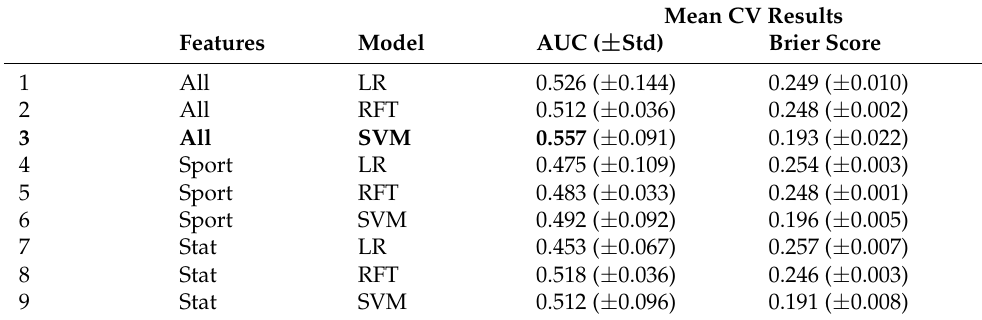
Table 4. Results for the models trained using only the entire dataset for different sets of features and algorithms. Either all features (All), only the sports-specific features (Sport), or only the statistical features (Stat) are used. The reported values are a mean across the scores obtained for each of the five CV